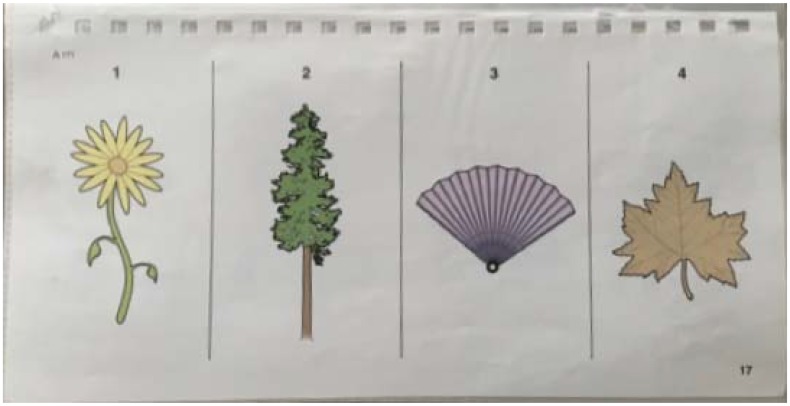
Example page of the Receptive One Word Picture Vocabulary Test – Fourth Edition (Martin and Brownell, 2010).